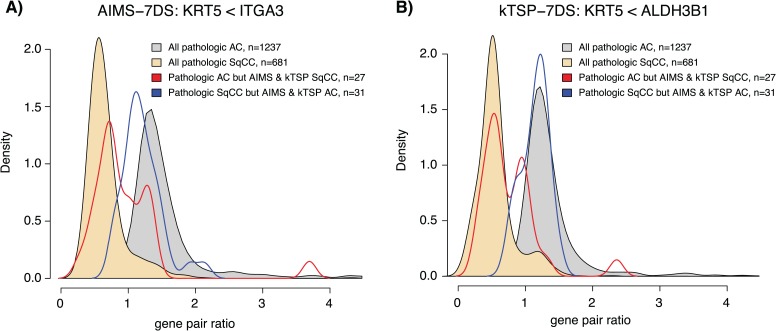
Characteristics of misclassified tumors in the histology case study arm. Gene pair rules were obtained from respective 7DS training data set for AIMS and kTSP. (A) Gene pair ratios for the AIMS KRT5<ITGA3 gene rule stratified by tumor histology and SSP class. (B) Gene pair ratios for the kTSP KRT5<ALDH3B1 gene rule stratified by tumor histology and SSP class. Density plots were created using the density() function in R.